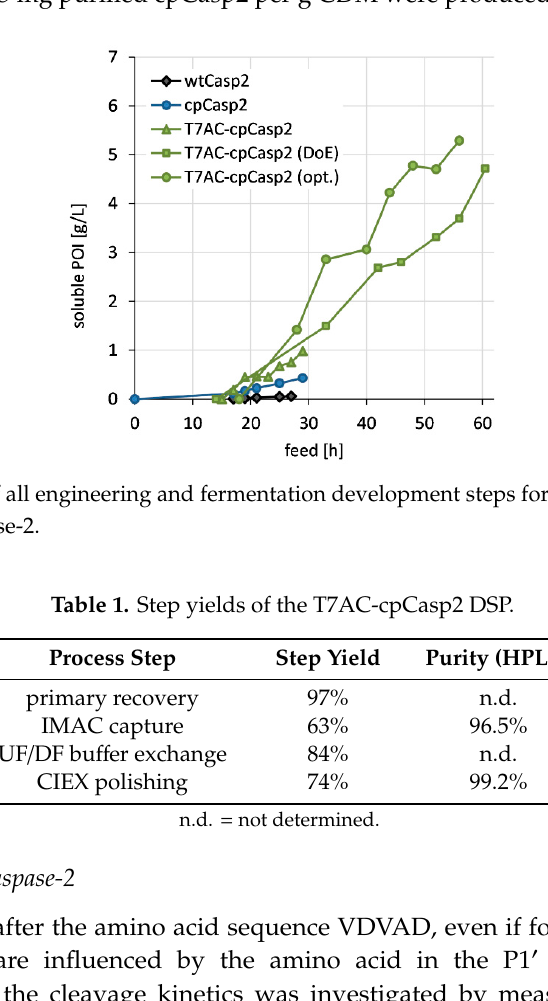
Table 1. Step yields of the T7AC-cpCasp2 DSP.